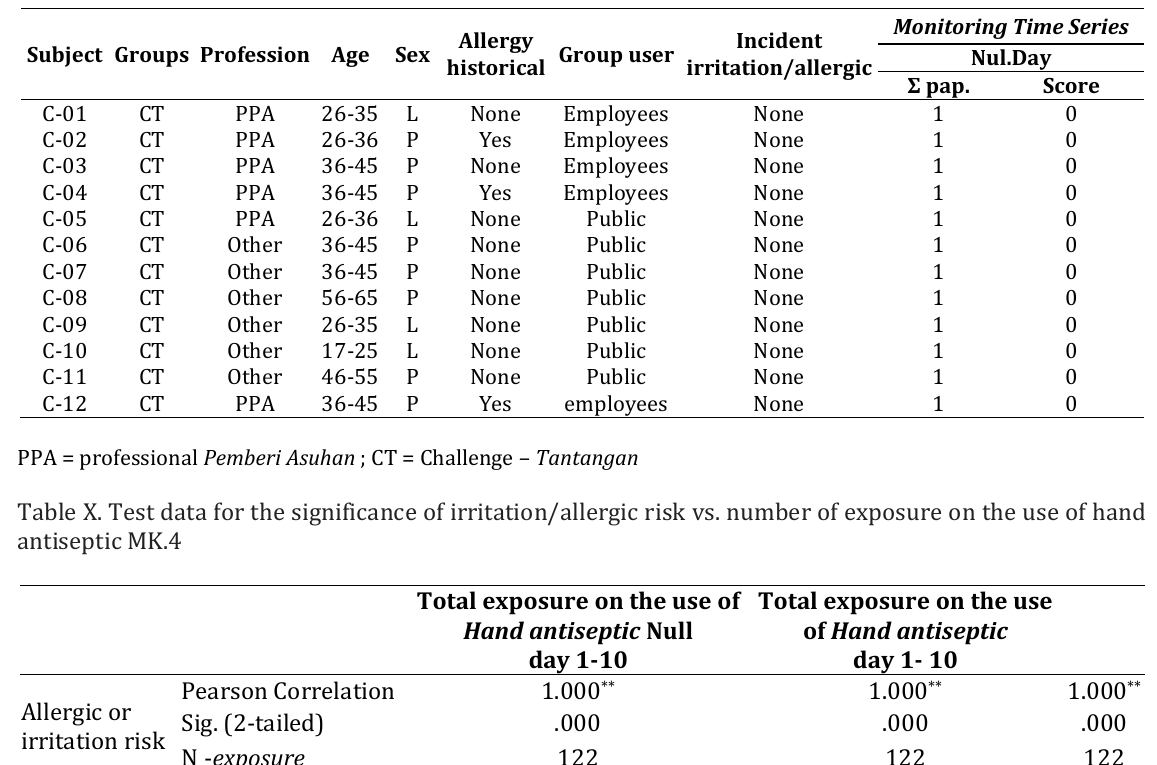
Table IX. Monitoring Time Series exposure on the challenge group